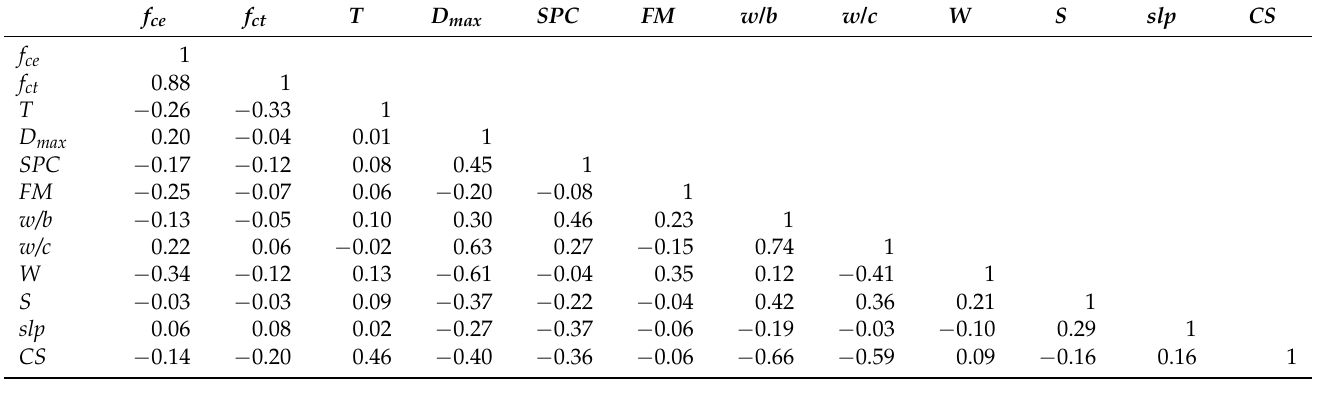
Table 2. Pearson’s correlation coefficient among the variables used in the development of models.